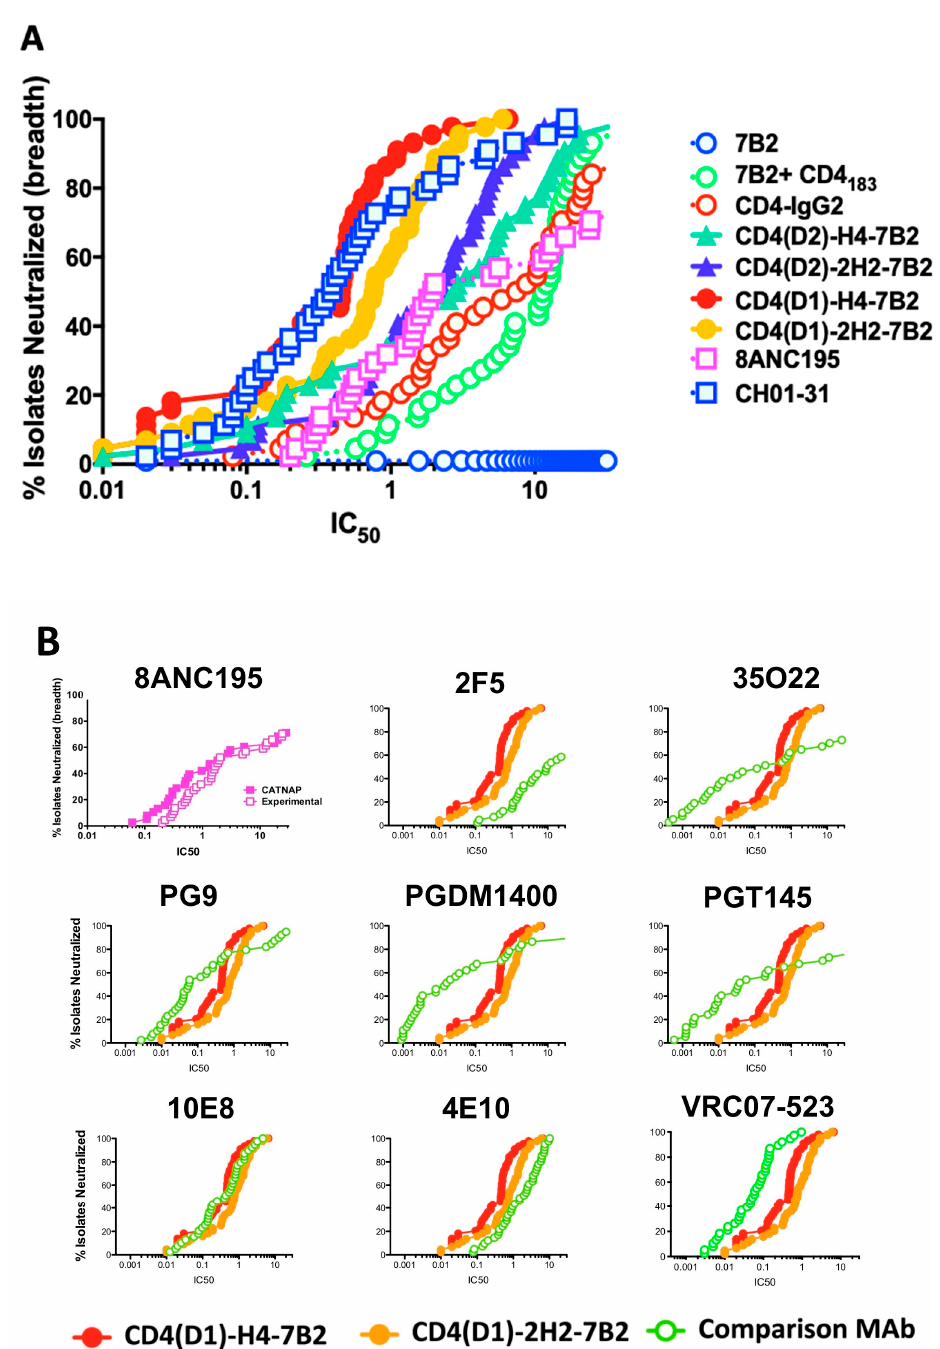
Figure 5. Neutralization by mAbs and Ig-Adhesins. Neutralization was studied using the TZM-bl assay with 44 different tier 1 and 2 pseudotyped HIV isolates ( A ). The panel of mAbs and Ig-adhesins, along with a mixture of CH01+CH31 neutralizing mAbs was tested for potency and breadth of neutralization. Vertical axis is percentage of isolates neutralized, the horizontal is IC 50 ( µ g/mL) ( B ). Comparison of experimental results with historical data in CATNAP. The upper left panel compares mAb 8ANC195 experimental vs historical data. The remainder compare two Ig-Adhesins to other potent, broadly-neutralizing mAbs. Axes are the